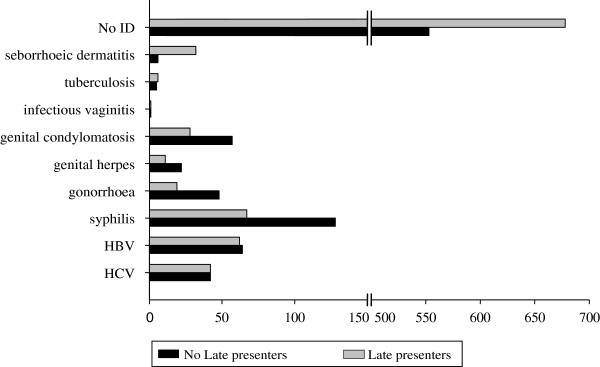
Distribution of indicator diseases by late presentation (CD4 < 350 cells/mmc or an AIDS-defining event).